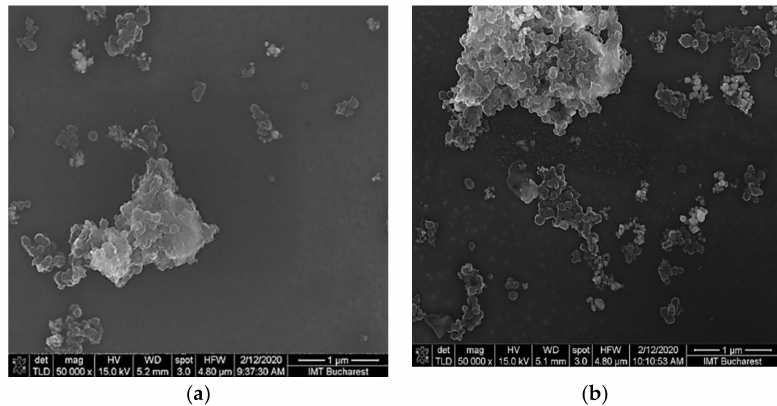
Figure 2. SEM images of the sensing ternary films deposited on the sensing area of the test structure. ( a ) Oxidized-single walled carbon nanohorns-SnO 2 -polyvinylpyrrolidone (ox-SWCNH / SnO 2 / PVP) = 1 / 1 / 1; ( b ) and ox-SWCNH / SnO 2 = 2 / 1 /